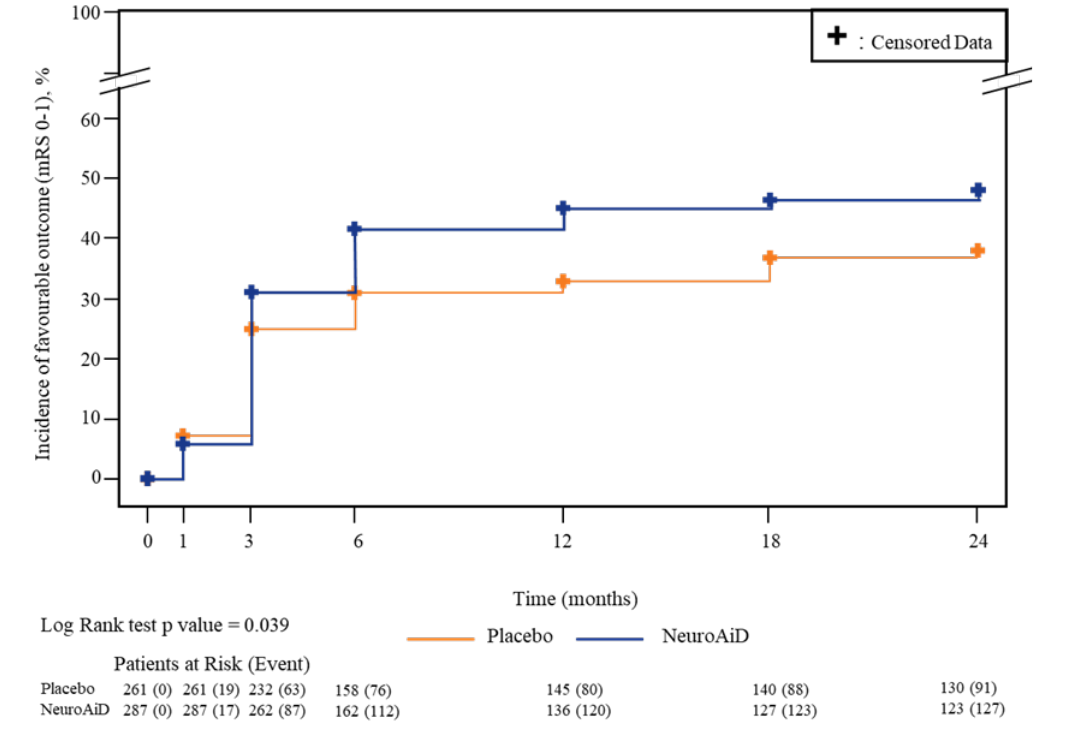
Figure 2. Kaplan – Meier plot for cumulative incidence of patients that achieved functional recovery (mRS 0 – 1). Table 2. Time to achieve functional recovery (mRS 0–1): Functional recovery rates and hazard ratio (MLC601 vs. Placebo) in the whole study